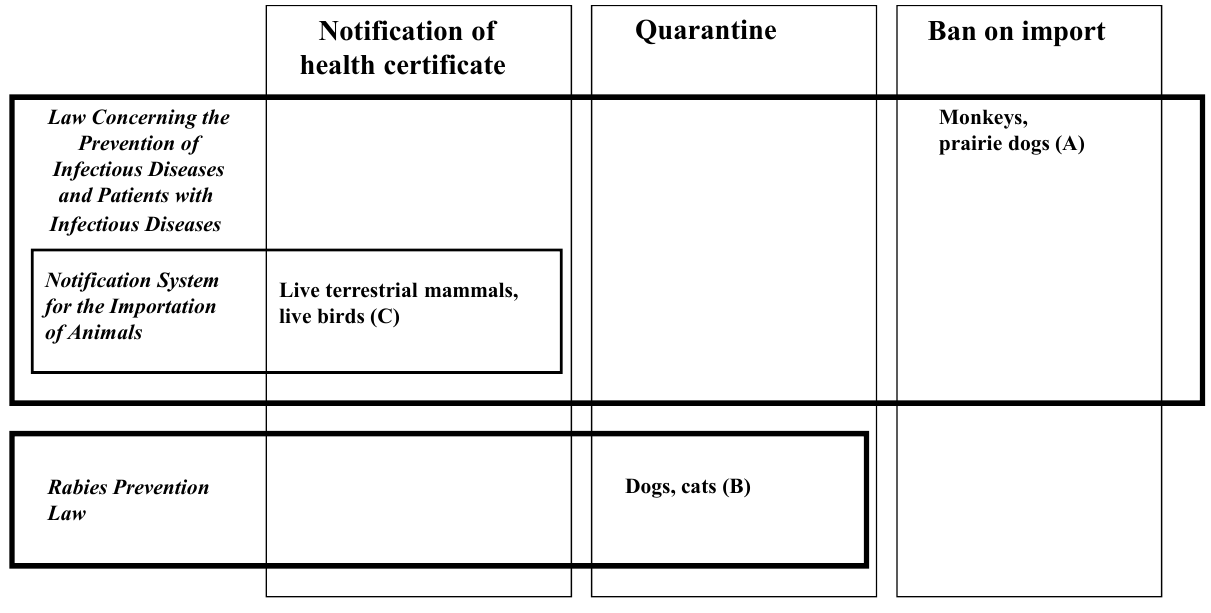
Figure 1. Regulatory framework for the restriction of imports of companion animals